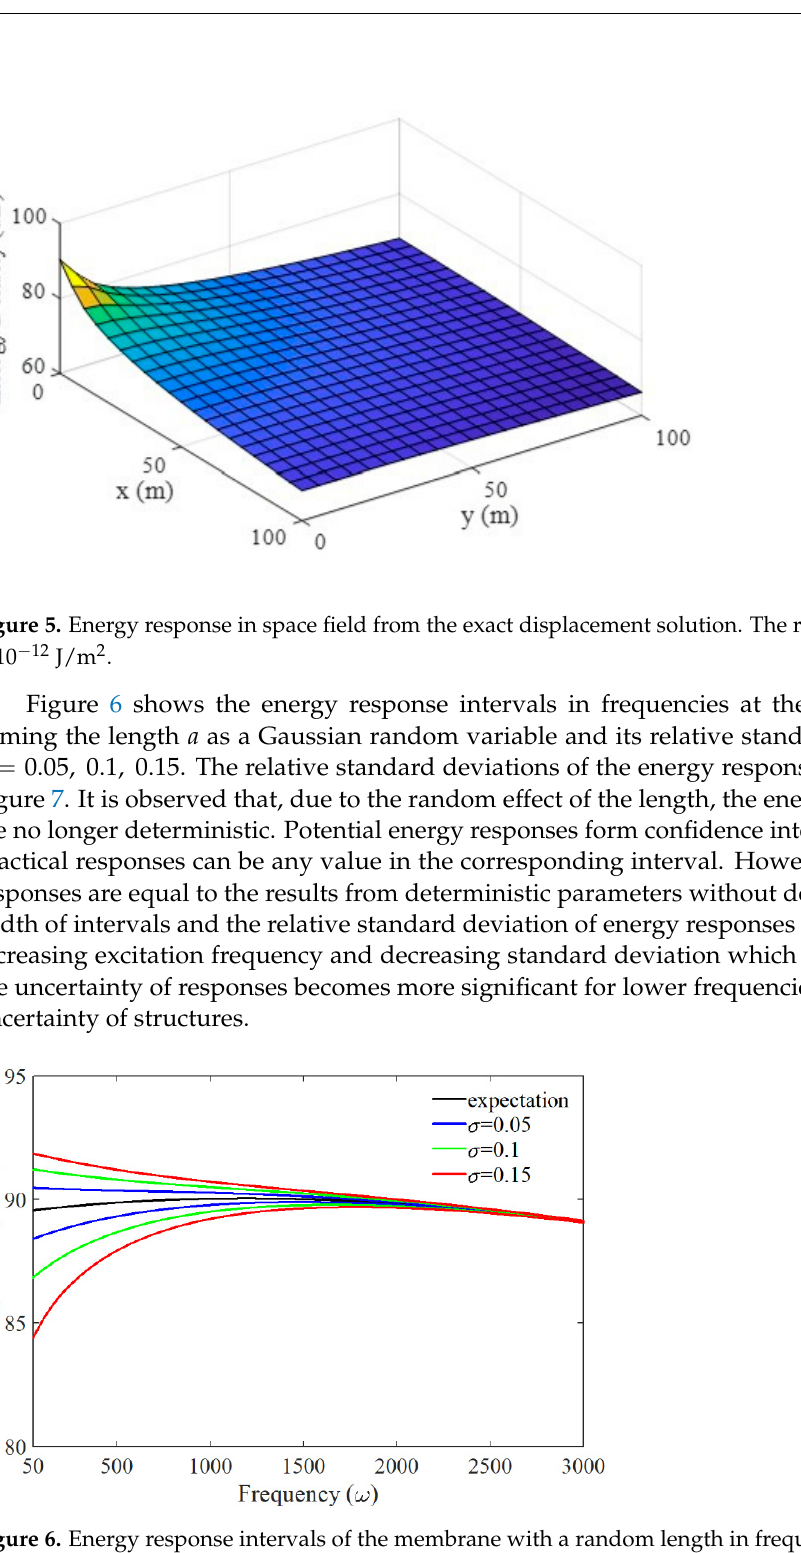
Figure 7. Relative standard deviations of energy response of the membrane with a random length in frequency field. The reference energy is 10 − 12 J/m 2 . Figure 8. Standard deviation of energy response of the membrane with a random length in space field. The reference energy is 10 − 12 J/m 2 . 500